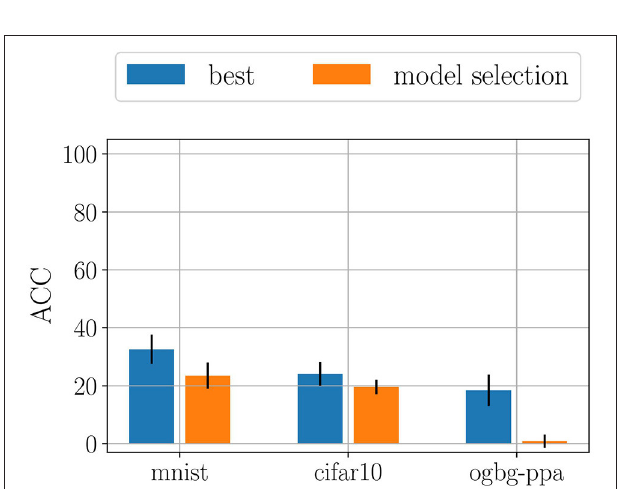
FIGURE 2 | Comparison of performances between model selection (averaged across all configurations) and model assessment (averaged across 5 final training runs). The difference highlights the sensitivity of LwF to the choice of hyperparameters. Most of the configurations cause larger forgetting effects with respect to the best configuration found by model